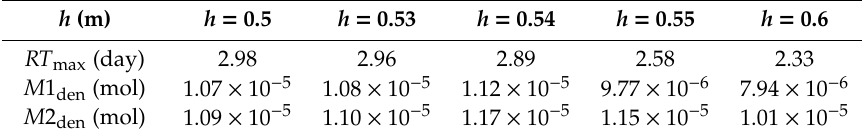
Table 5. Comparison among the denitrification simulation results with five weir heights ( h